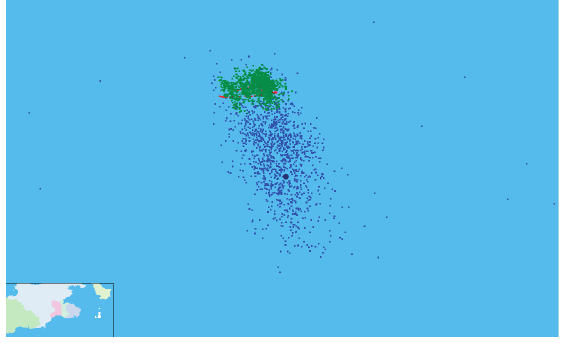
Figure 15. Real-time experimental results for the static position.